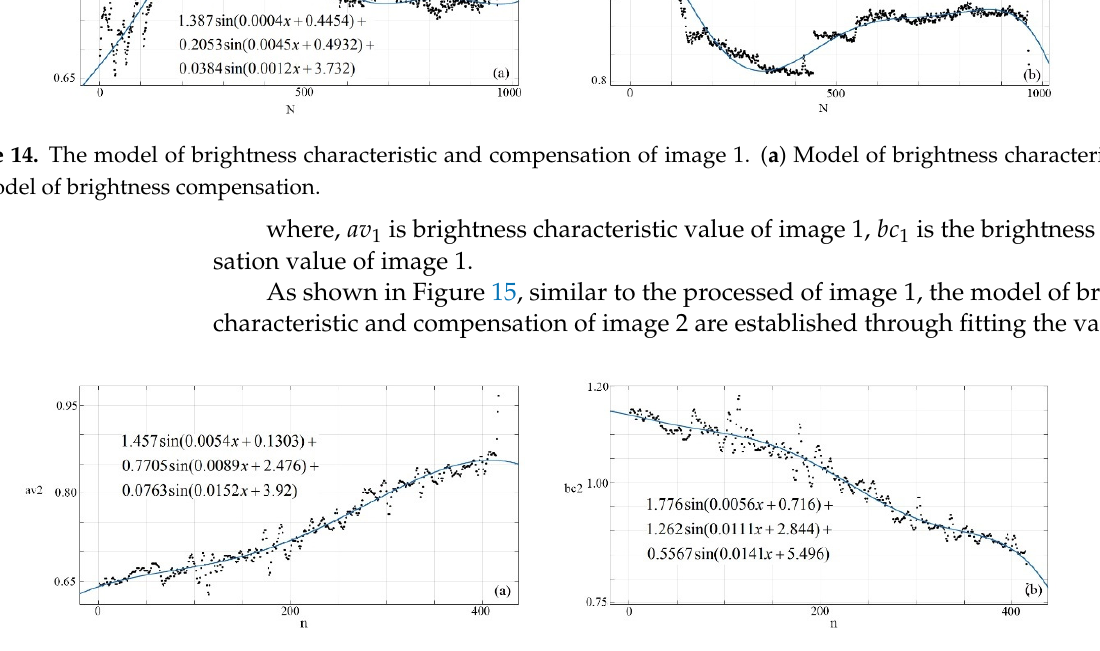
Figure 15. The model of brightness characteristic and compensation of region 1. ( a ) Model of brightness characteristic. ( b ) Model of brightness compensation.